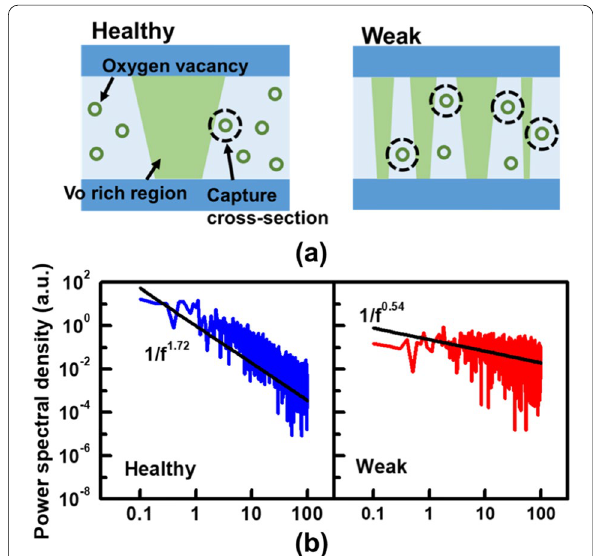
Fig. 7 a Illustrations of the filaments and trap states on the TMO layer in healthy/weak. b Corresponding fitting trends in noise